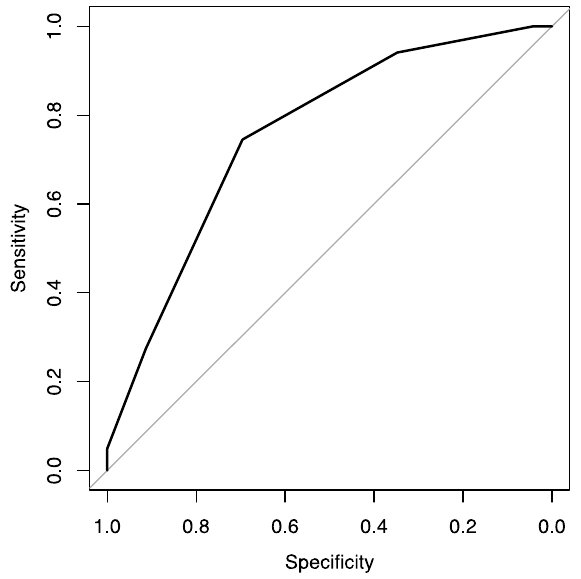
Figure 3. ROC curve showing the F6 parameter’s potentiality in the grade prediction.